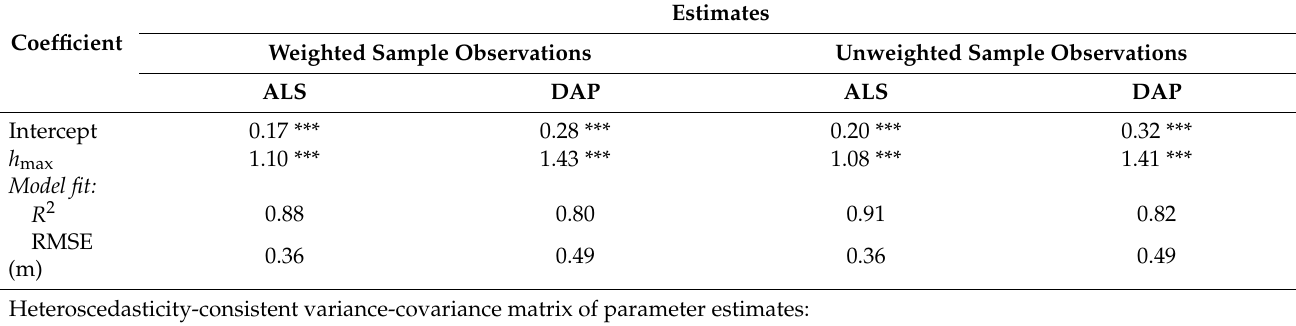
Table 10. Estimation results for regression models for vegetation height shown in Equation (5). The models were used in the estimation of vegetation height ( n =